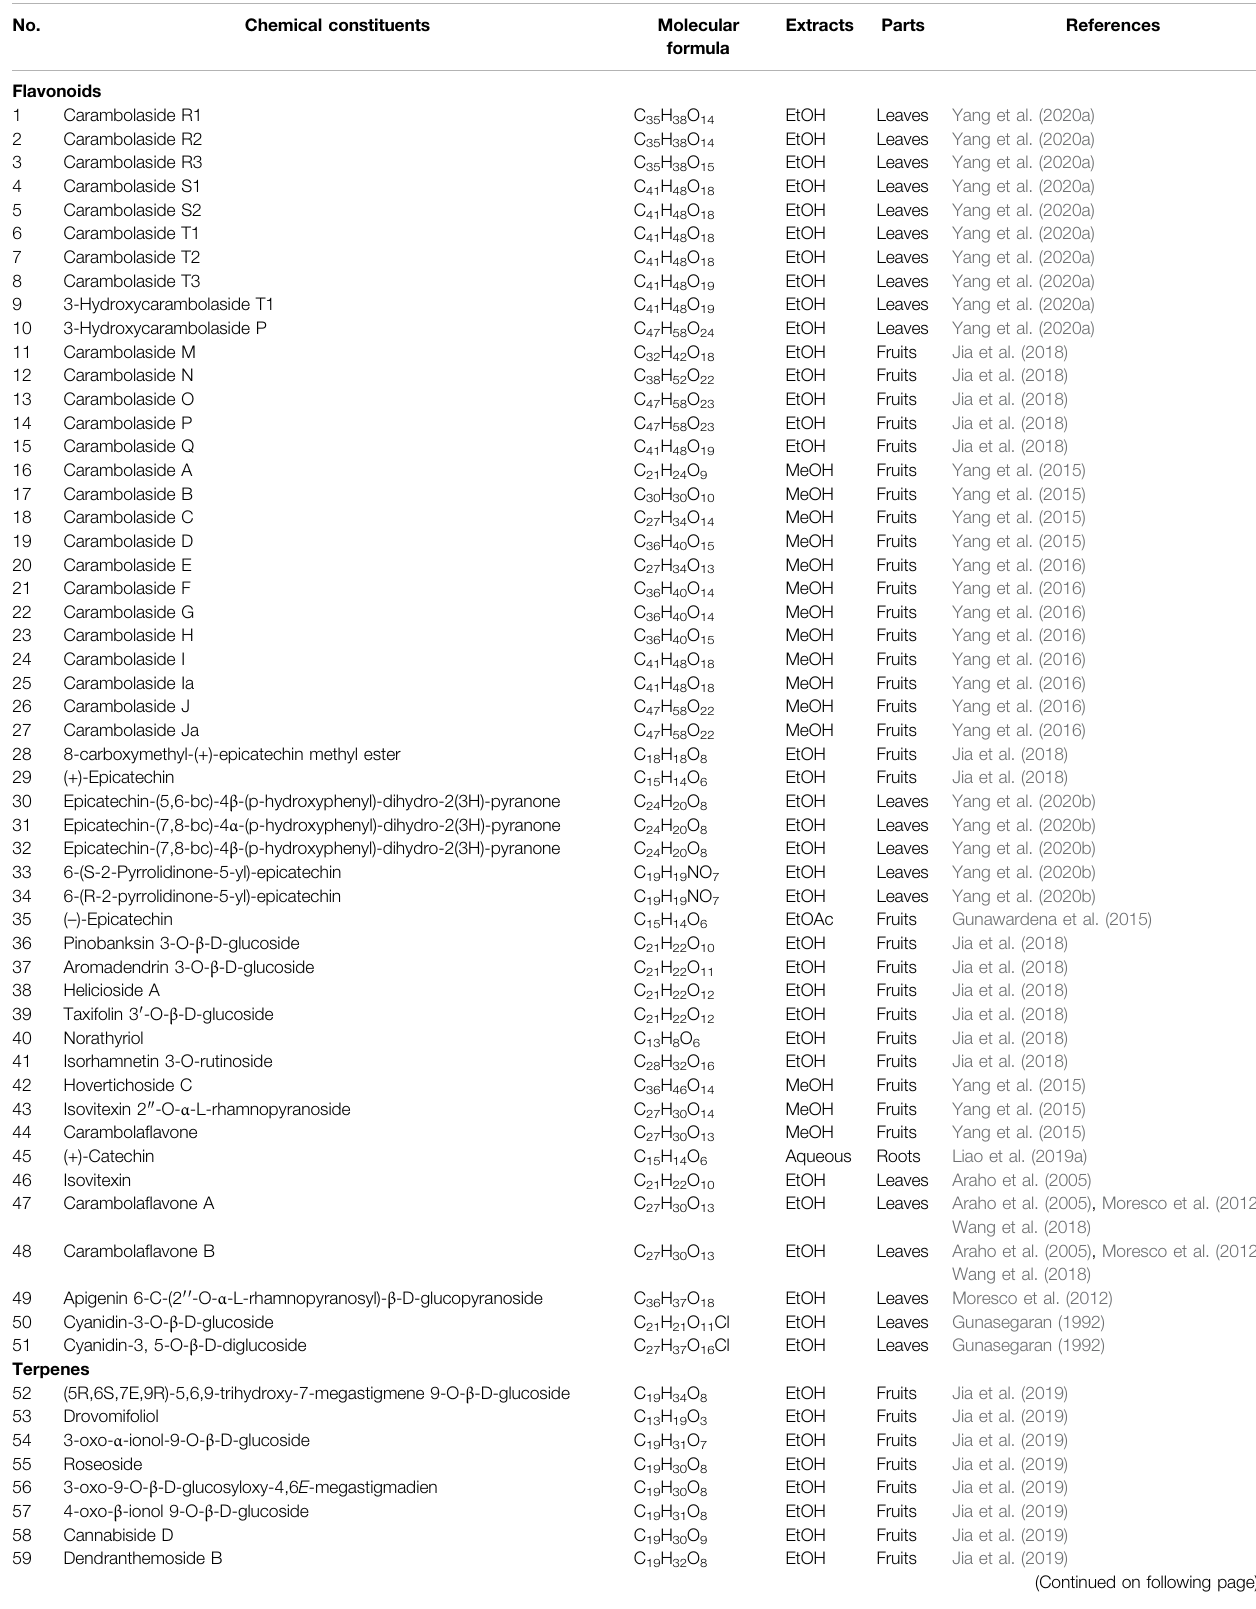
TABLE 1 | Chemical components isolated and structurally identi fi ed from A. carambola .